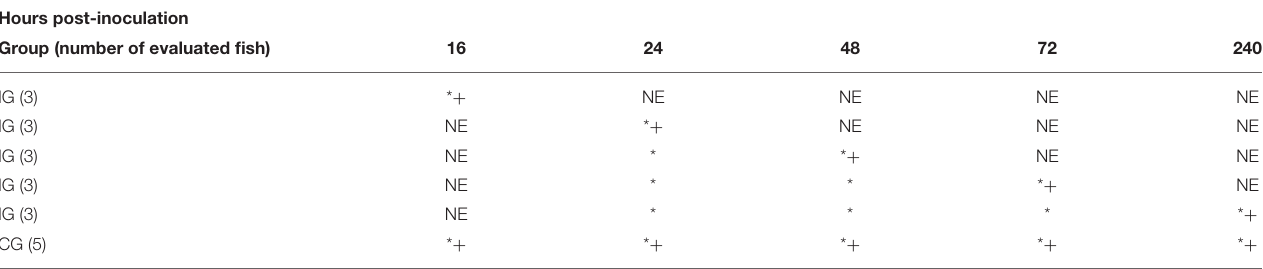
TABLE 1 | Assessment of T. canis eggs of the aquatic environment ( * ) and larvae in fish tissues ( + ), after Nile tilapia experimental inoculation [inoculated group (IG), n = 15] with embryonated eggs. Hours